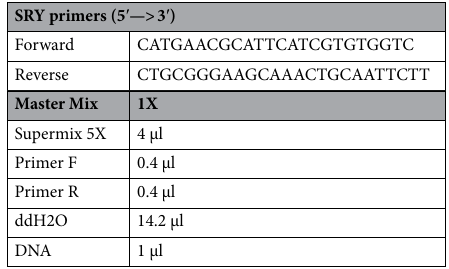
Table 5. SRY primers and Master Mix for the